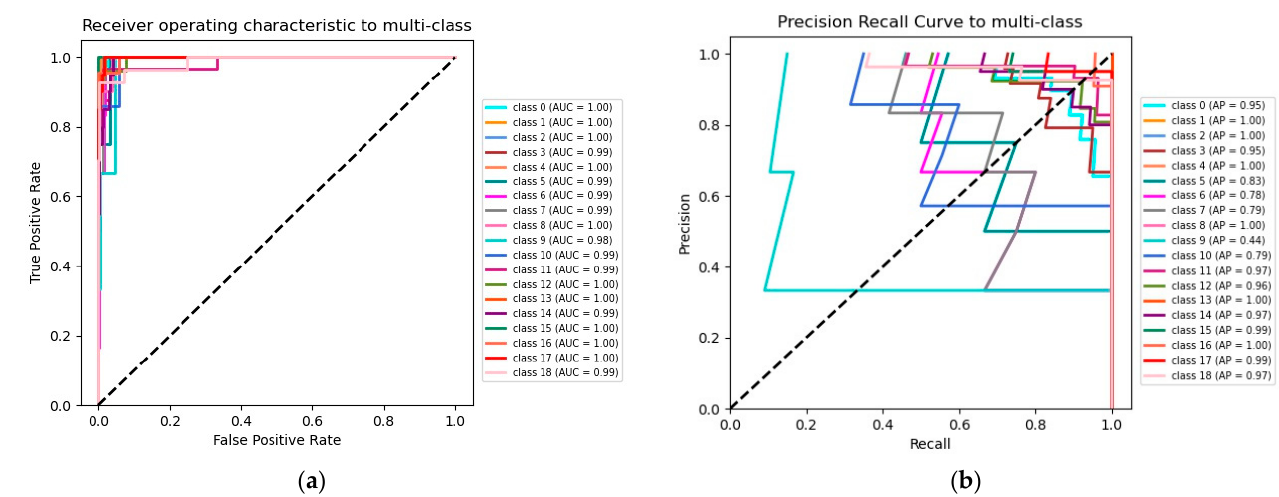
Figure 11. ( a ) ROC (receiver operating characteristic) curve of the ReVI_3b. ( b ) PR curve (precision– recall curve) of the ReVI_3b.